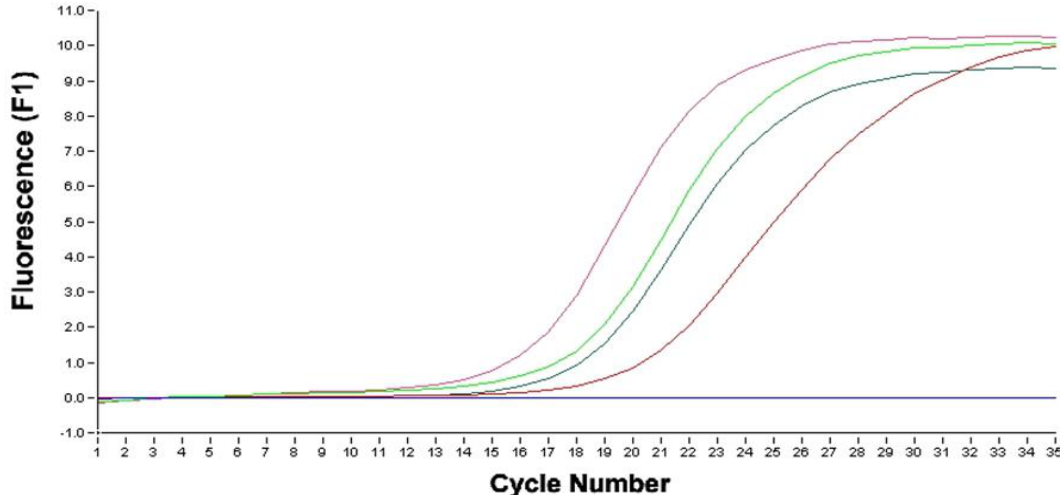
Figure 3. I caA gene expression level of S.epidermidis 734 with gyrB as the reference. Blueline indicated NTC icaA, Light green line indicated 0% icaA, dark red line indicated 5% icaA, Blackline indicated NTCgyrB, Pinkline indicated 0%gyrB, dark greenline indicated 5% gyrB